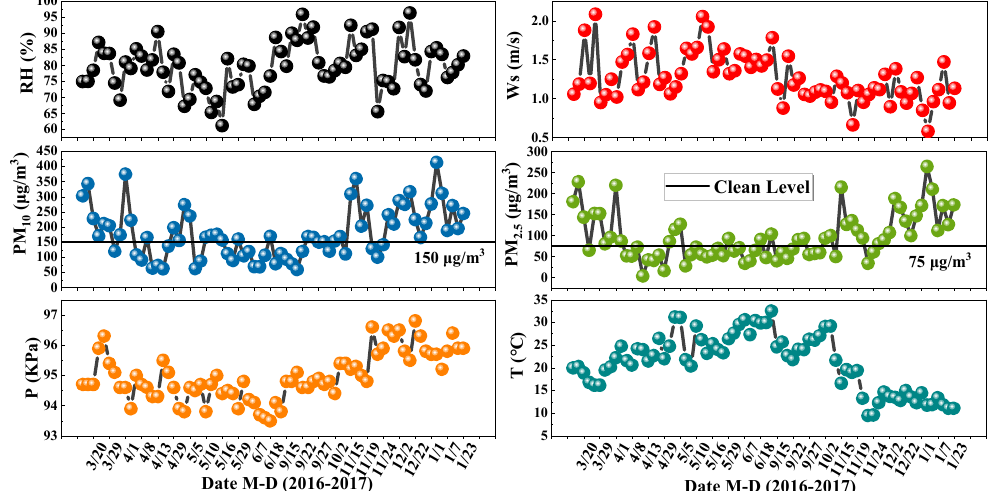
Figure 2. Time series of changes in PM mass concentration and related meteorological conditions. The concentrations of PM 2.5 that increase with the change in pollution levels were on average 48.80 μ g/m 3 , 109.84 μ g/m 3 , and 186.21 μ g/m 3 for Clean, Light-medium, and Heavy levels, respectively. The concentrations of PM 10 increase with the change in pollu- tion levels were 98.49 μ g/m 3 , 226.53 μ g/m 3 , and 383.21 μ g/m 3 for Clean, Light-medium, and Heavy levels, respectively (Figure 3b). From the perspective of the increase in parti- cle concentration, the growth rate of PM 10 is faster than the growth rate of PM 2.5 , indi- cating that coarse particles (PM 2.5–10 ) have a certain contribution to the growth of PM 10 . PM 2.5 /PM 10 from Clean to Heavy pollution decreases first and then increases slightly, in- dicating PM 2.5 contributed the most to PM 10 at Clean levels and the least to PM 10 at Severe levels.